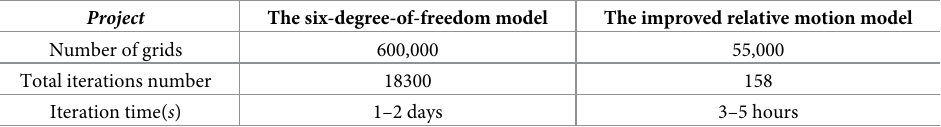
Table 1. Comparison of calculation process and results of two calculation